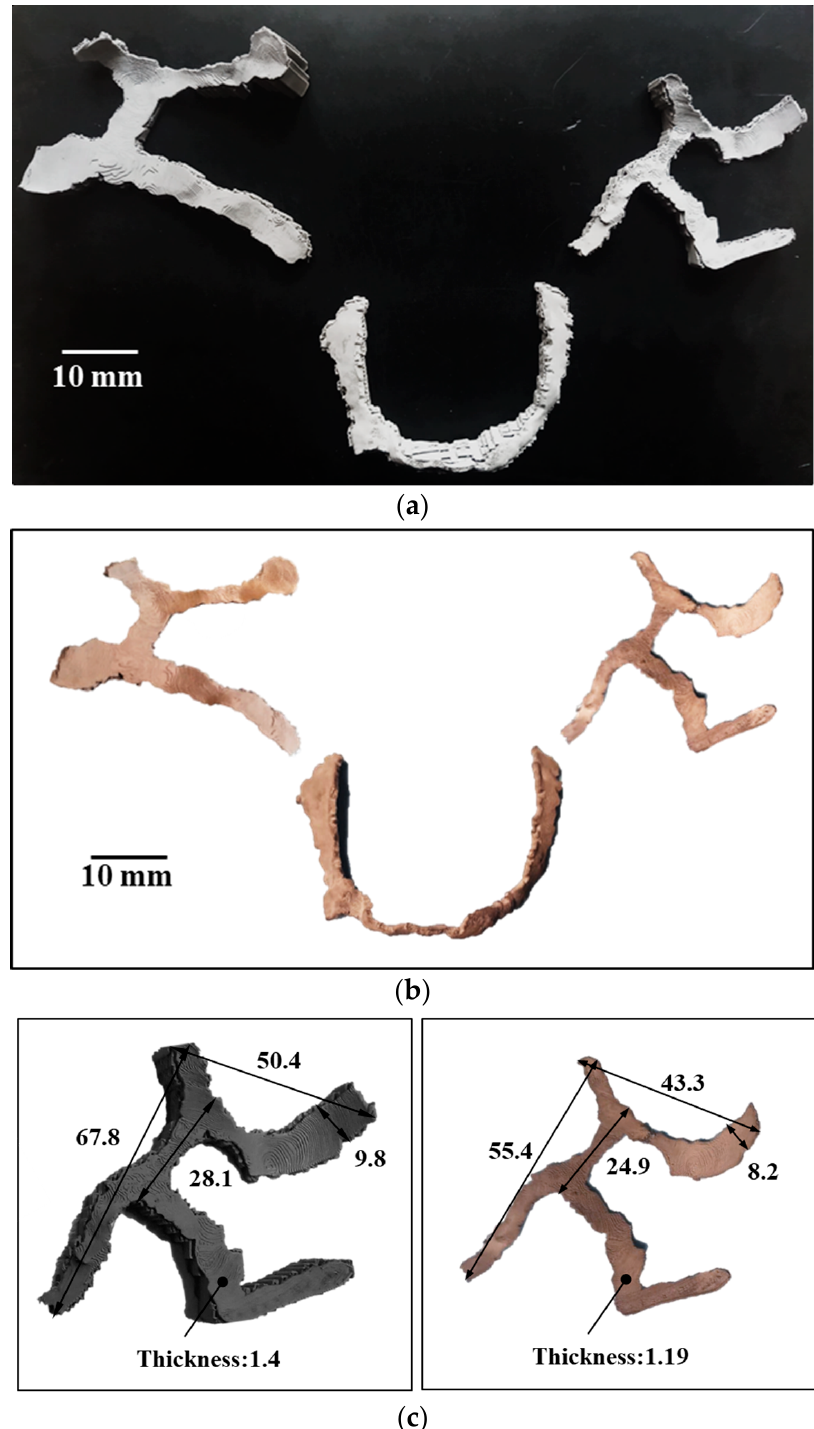
Figure 8. ( a ) Sintered metal parts with a support structure; ( b ) sintered metal parts after support structure removal; ( c ) green part vs sintered part dimensions showed 16% shrinkage in sintering.